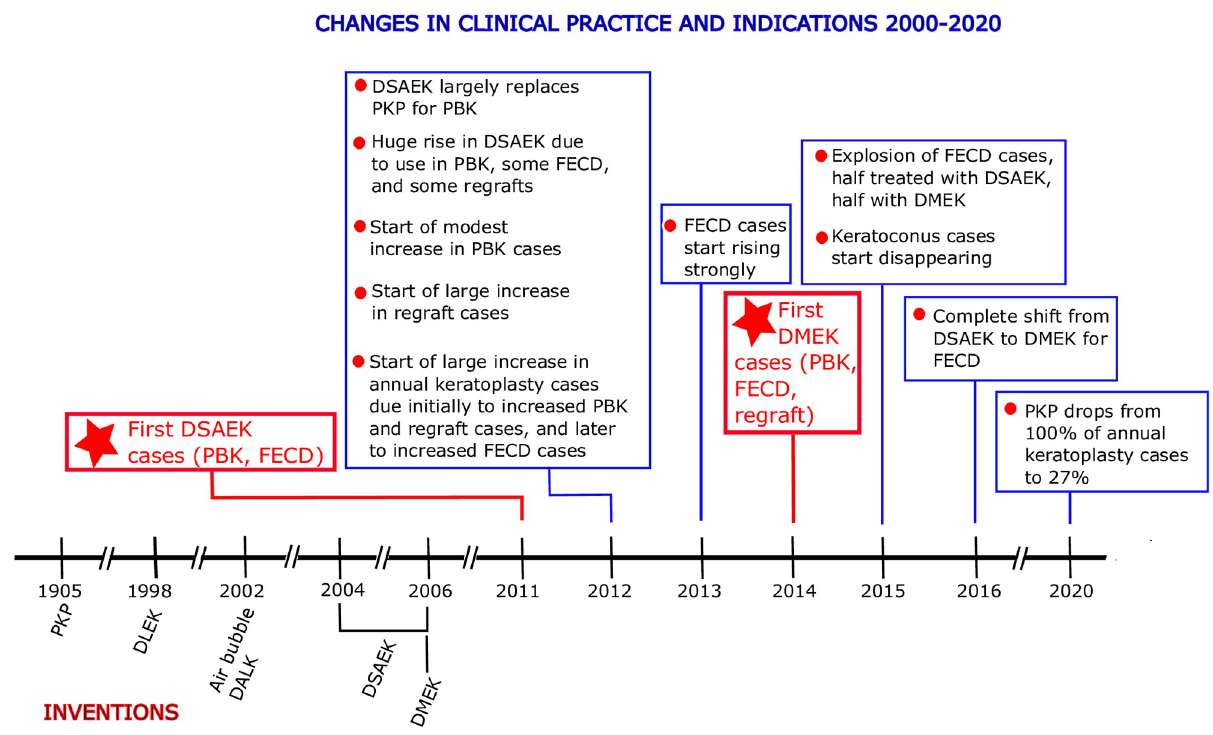
Fig 9. Timeline showing the inventions of PKP, DALK, DSAEK, and DMEK and their effects on our clinical practice and indications. DALK, deep anterior lamellar keratoplasty; DSAEK, Descemet stripping automated endothelial keratoplasty; DMEK, Descemet membrane endothelial keratoplasty; FECD, Fuchs endothelial cell dystrophy; PBK, pseudophakic bullous keratopathy; PKP, penetrating keratoplasty.